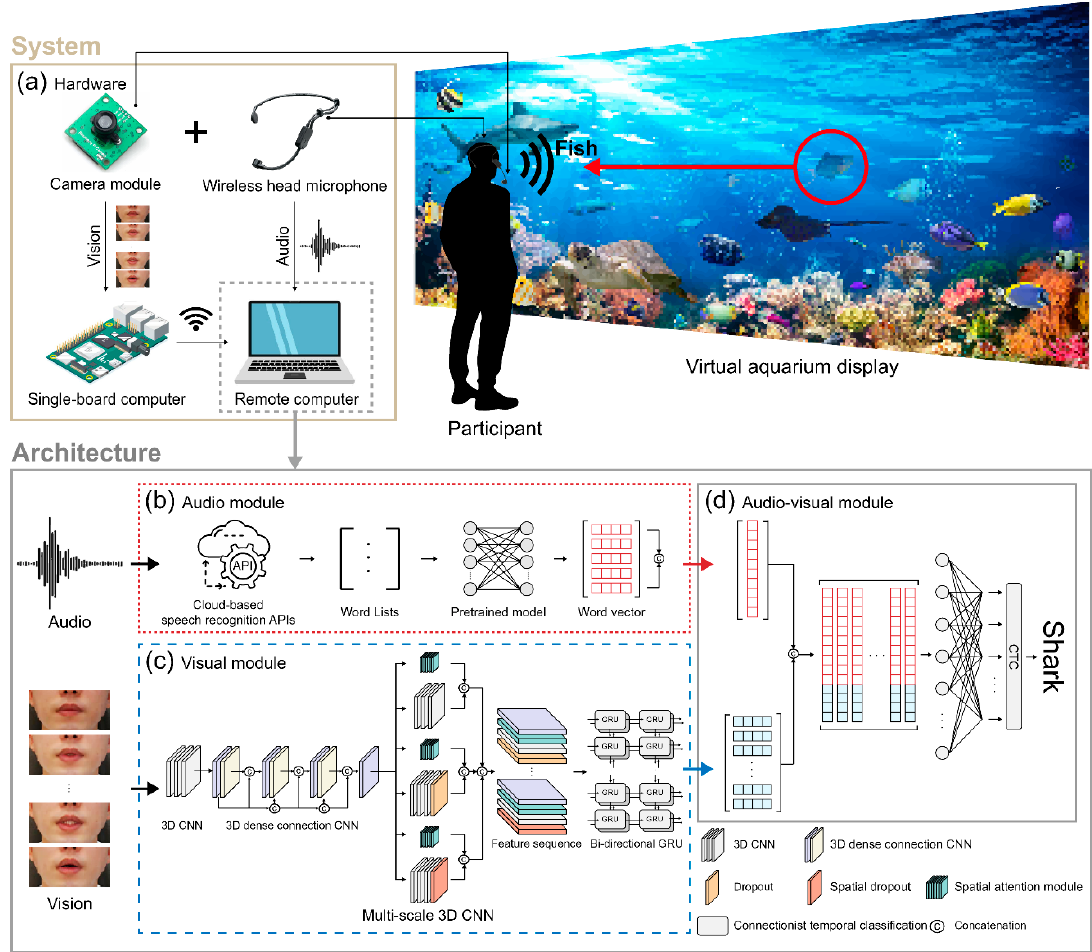
Figure 1. Composition of the proposed system and an example usage scenario. ( a ) Hardware components of the system and a virtual aquarium interaction usage scenario; ( b ) audio module for generating word vectors; ( c ) visual extraction module for extracting feature vectors; ( d ) audiovisual module for classification.